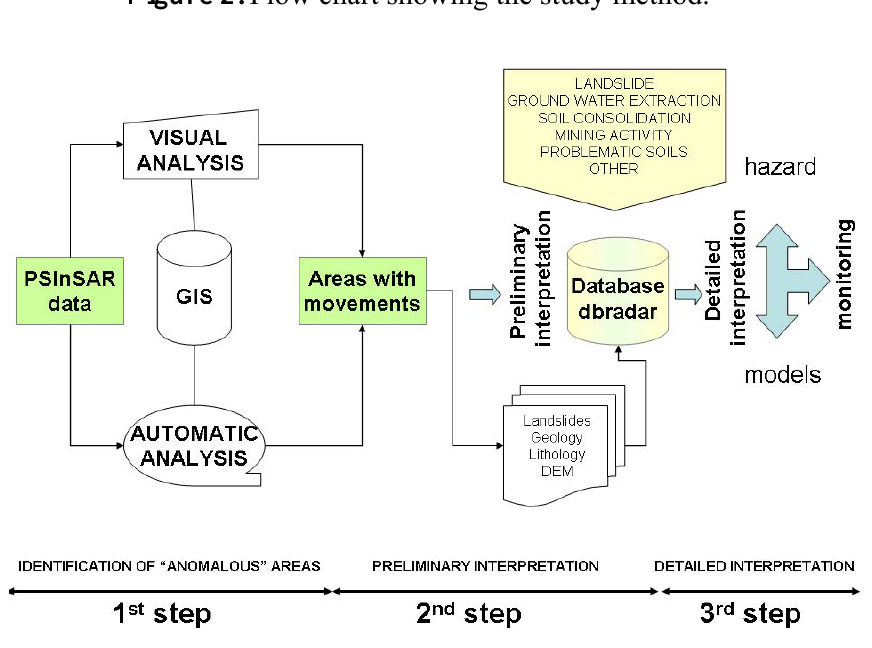
Figure 2. Flow chart showing the study